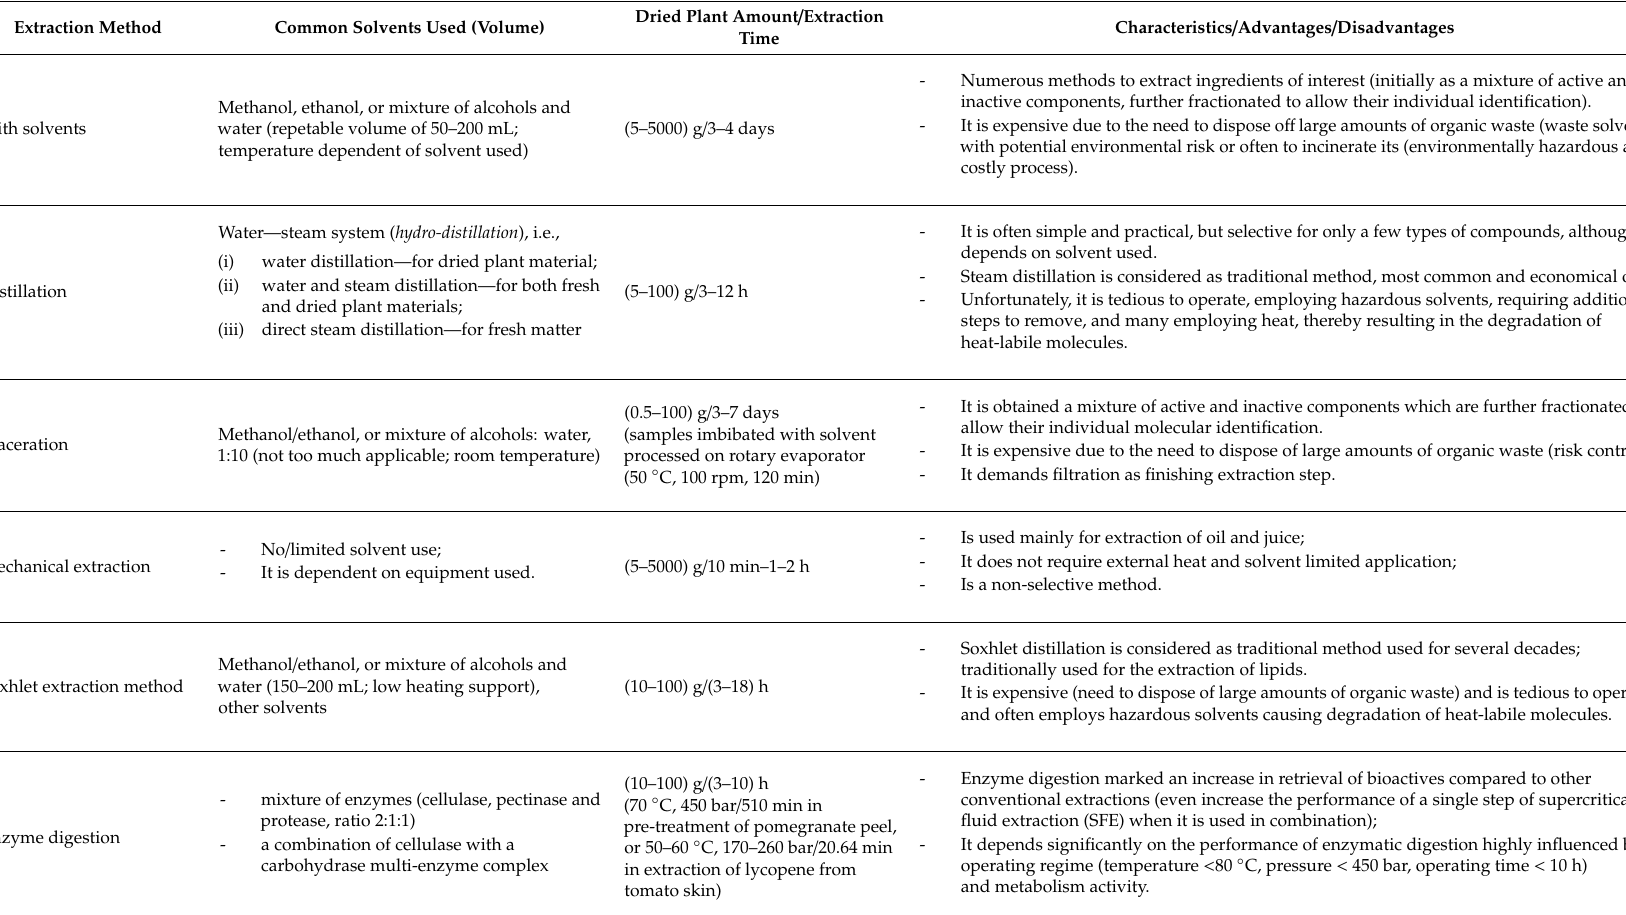
Table 3. Methods for extraction of active compounds from plants